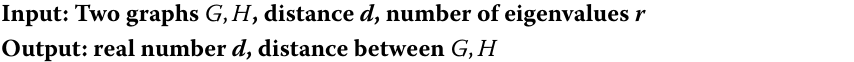
Algorithm 1 Non-Backtracking Spectral